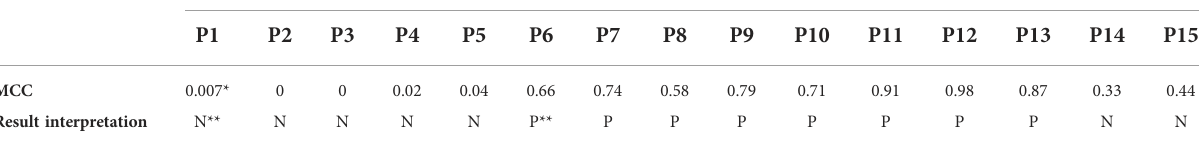
TABLE 6 The Raman spectroscopy test results of LD probable human blood